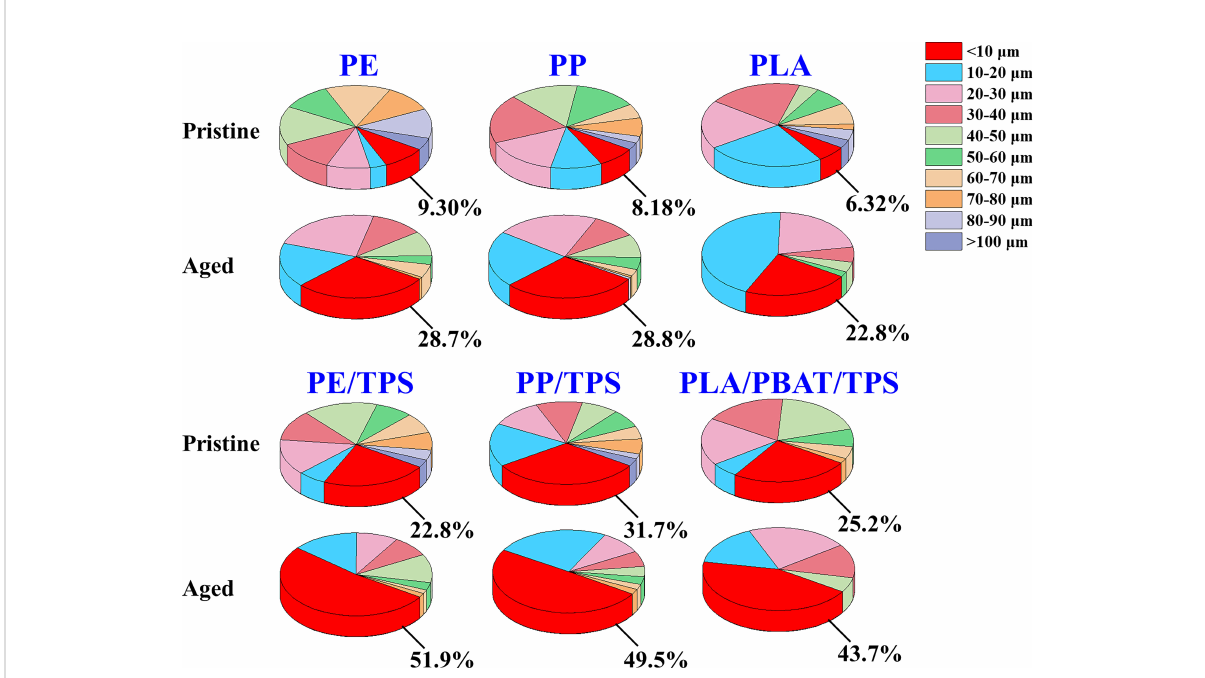
FIGURE 1 Size distributionof thepristineand agedMPs treatedby 2 monthsof UVirradiationinnatural seawater.Toobtainthesize distribution, allparticles( n >100) in the CLSMimages weremeasured using ImageJ software(http://imagej.net/) and three replicateswereused for eachtype of MP.PE, polyethylene; PP, polypropylene; PLA, polylactic acid; PE/TPS, polyethylene/thermoplastic starch blends; PP/TPS, polypropylene/thermoplasticstarch blends; and PLA/PBAT/TPS,polylactic acid/poly (butylene adipate- co -terephthalate)/thermoplasticstarch